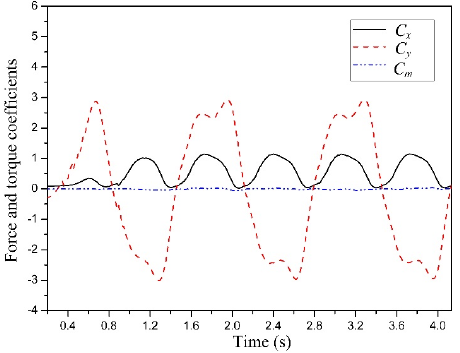
Figure 7. Performance curves of caudal fin.